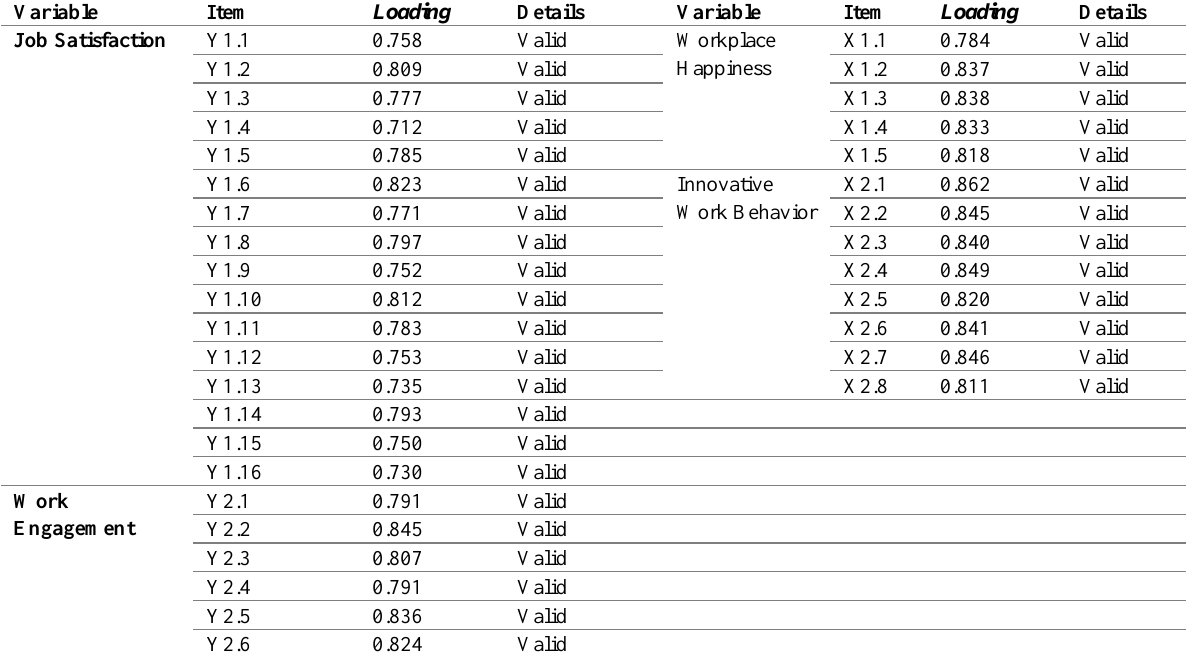
Figure 1: Measurement Results of Outer Model Table 1: Loading Factor